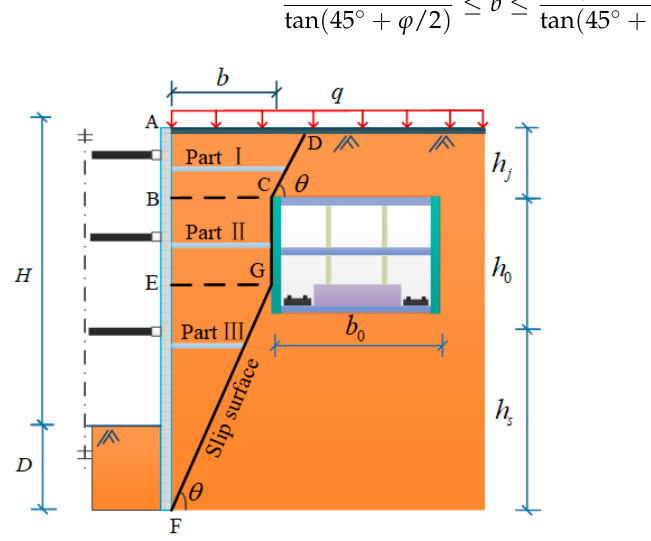
Figure 4. Calculation model of finite soil pressure.